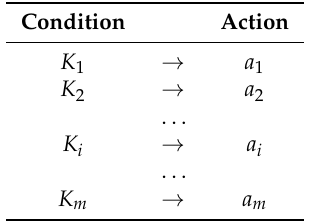
Table 1. Structure of a generic TR